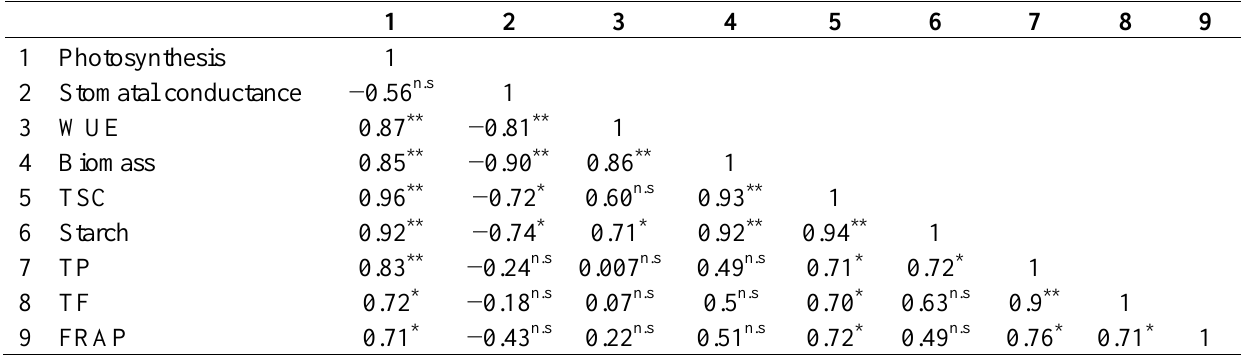
Table 2. Correlation between studied